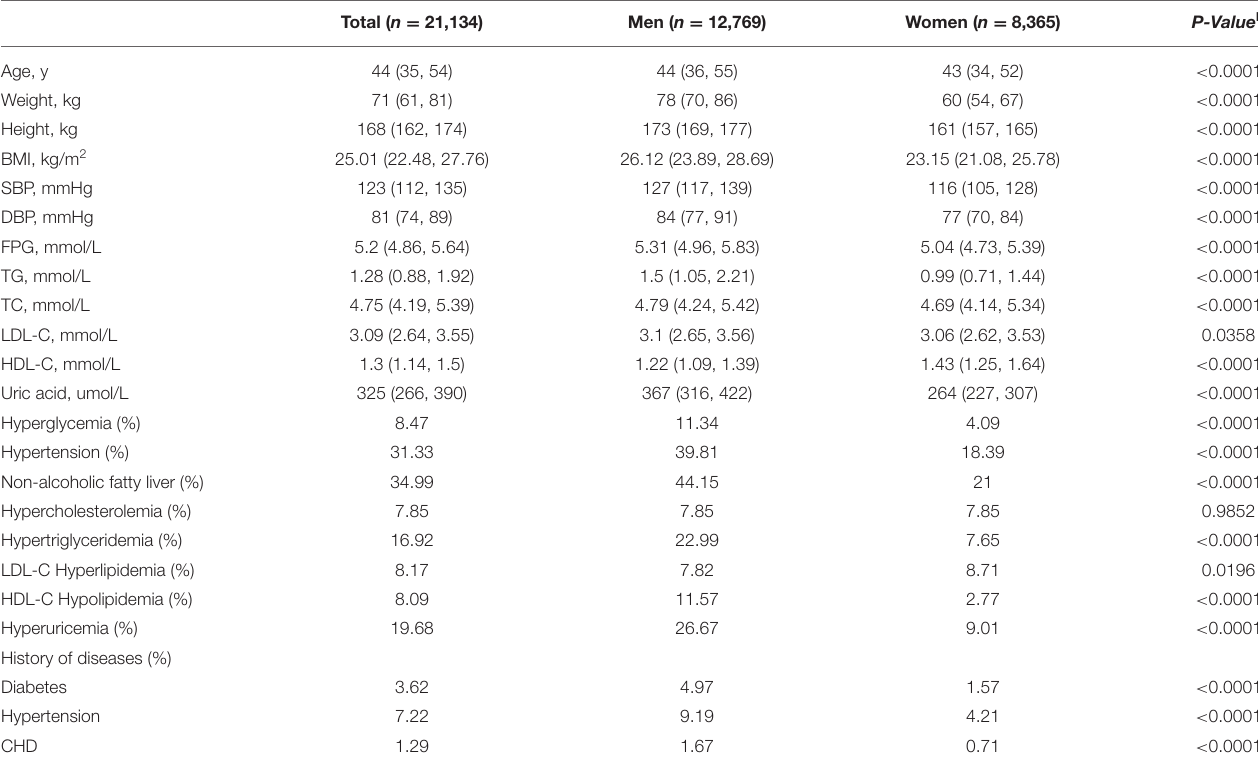
TABLE 1 | Characteristics of the study population according to sex a